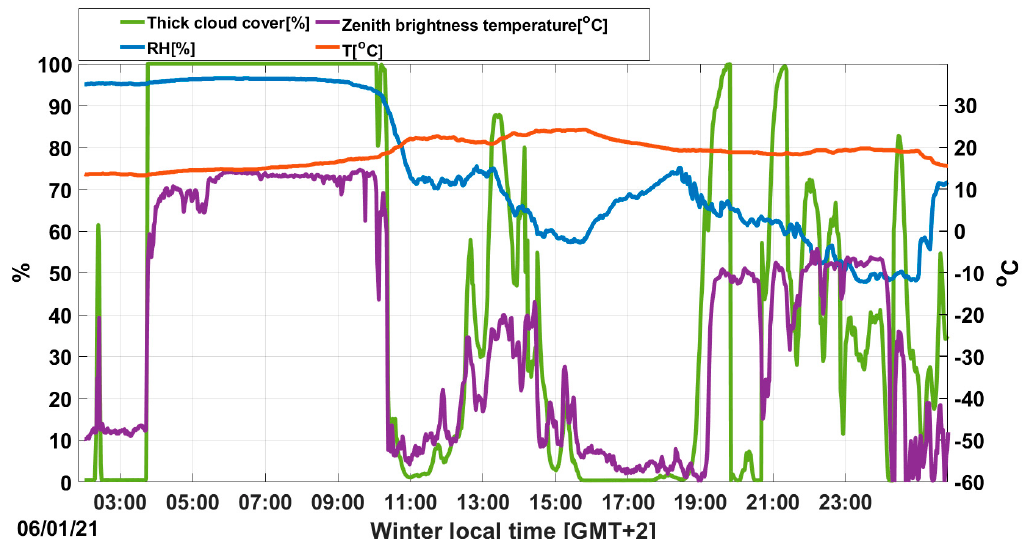
Figure 10. Cloud cover and zenith brightness temperature report during the fog event of 6 January 2021, calculated from WSI data. Note that the relative humidity and the air temperature are taken directly from the sensors embedded in Asis1i. Therefore, their values represent much more accurately the true values near the sensor. However, the humidity sensor cannot measure RH above 97.8% (compared to Figure 9).